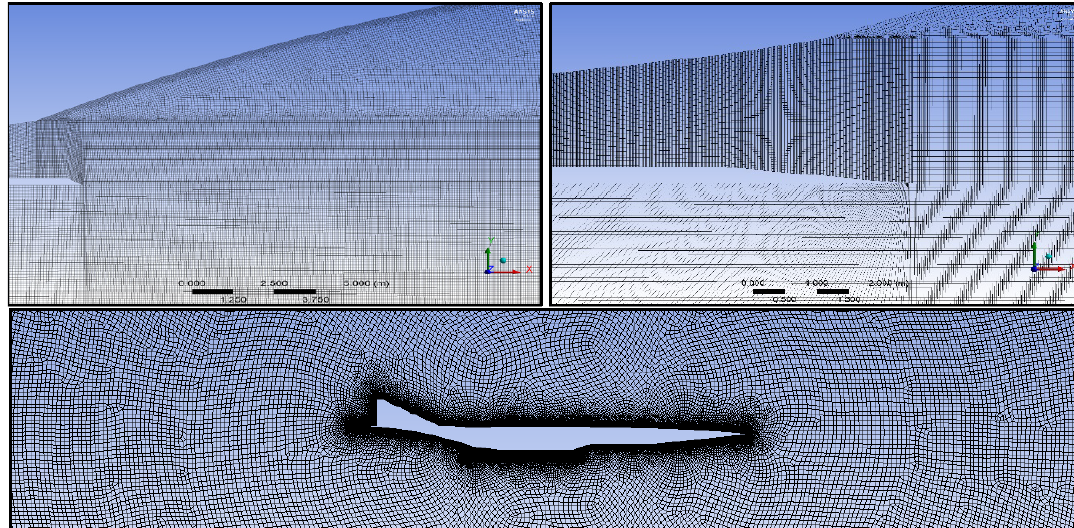
Figure 4. Sections of 2D mesh for the nozzle ( top left ), scramjet engine ( top right ), and integrated aircraft and scramjet engine ( bottom ).